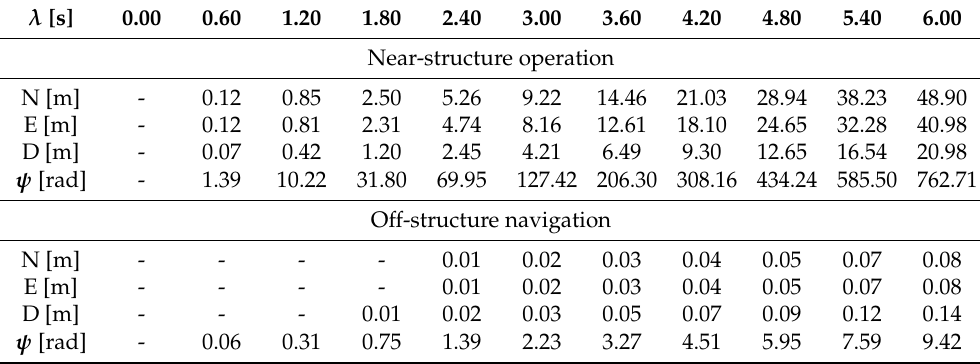
Table 11. Selected values for (cid:107) SG (cid:107) ∞ , min .